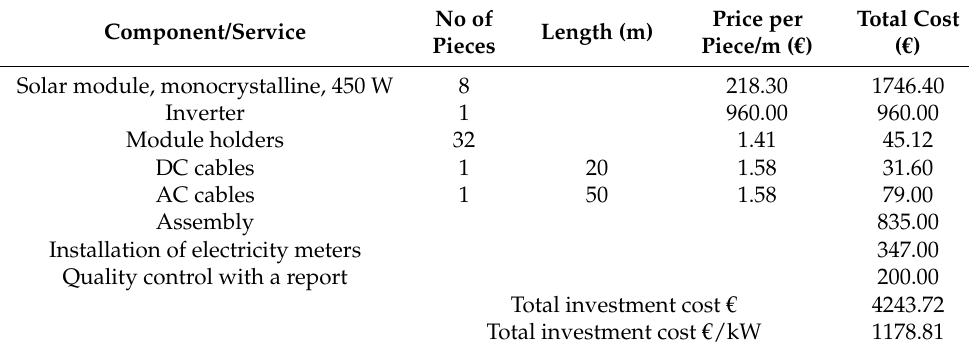
Table 4. Investment costs by purchasing components at the lowest prices on the